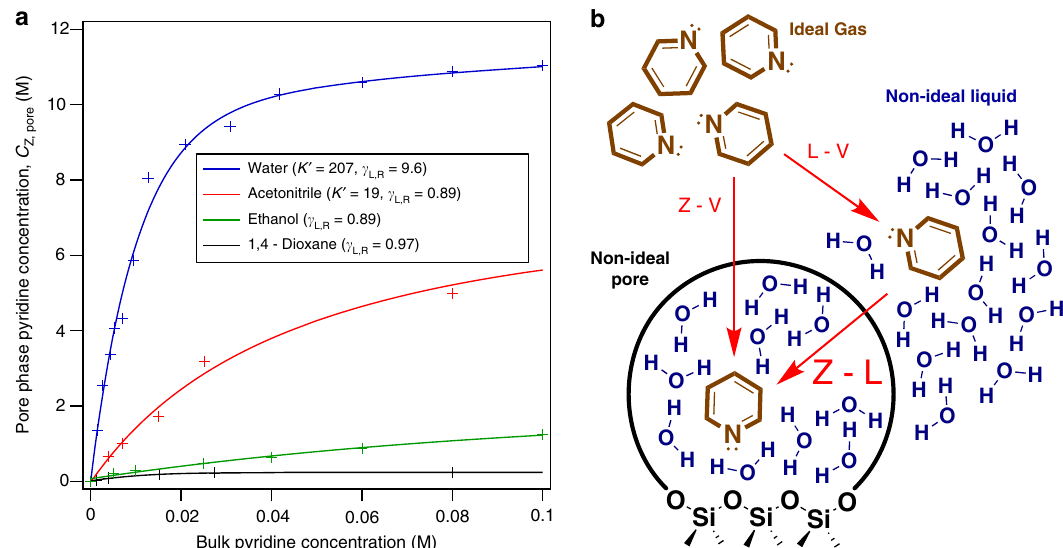
Fig. 3 Pyridine adsorption isotherms on siliceous Beta in various solvents. a Pyridine adsorption isotherms on Si/Beta (hydrophilic) at 20 °C in various solvents. b A Haber cycle for vapor-liquid-zeolite pyridine adsorption into water-saturated Si/Beta. Ideal gas pyridine may be used as a common reference state for all solvents to deconvolute the energetic contributions of bulk liquid solvation outside the pore from interactions within the pore. Z, L, and V refer to the zeolite, liquid, and vapor phases,